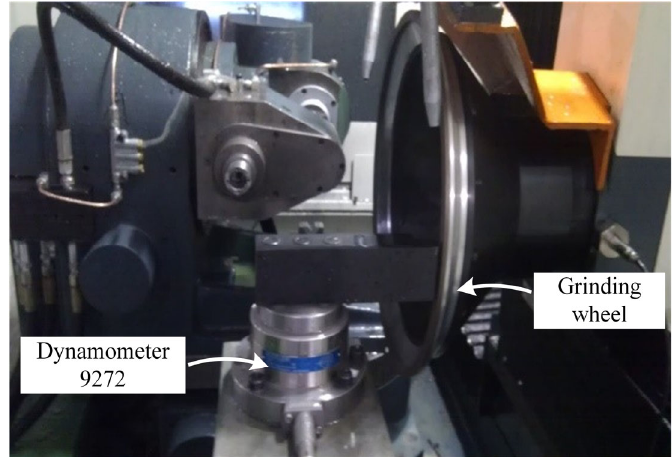
Figure 10. Grinding experimental device.